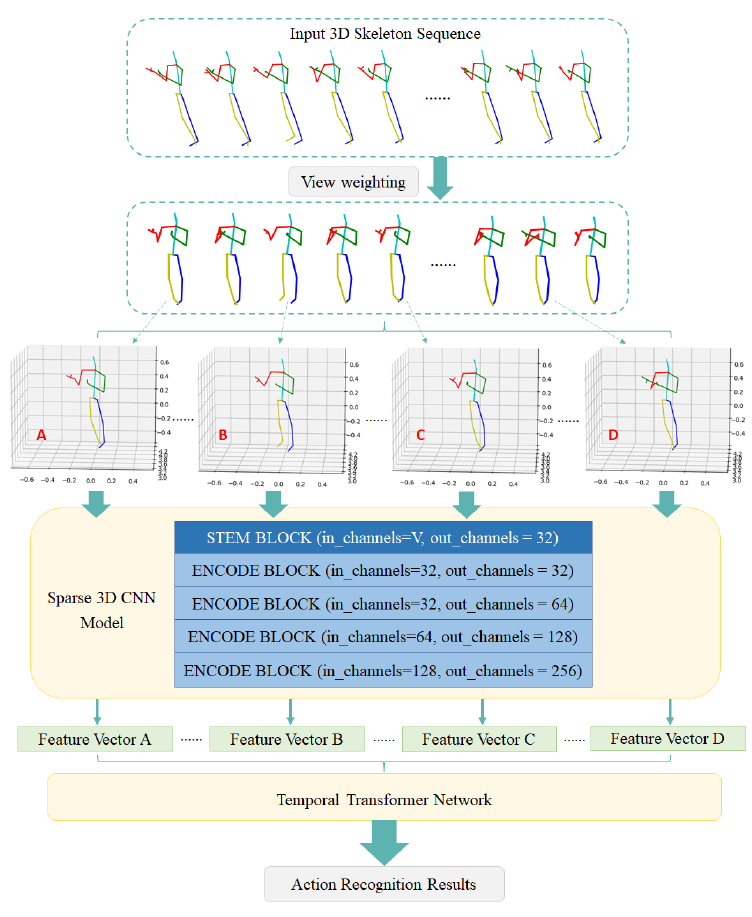
Figure 1. Diagram of the proposed